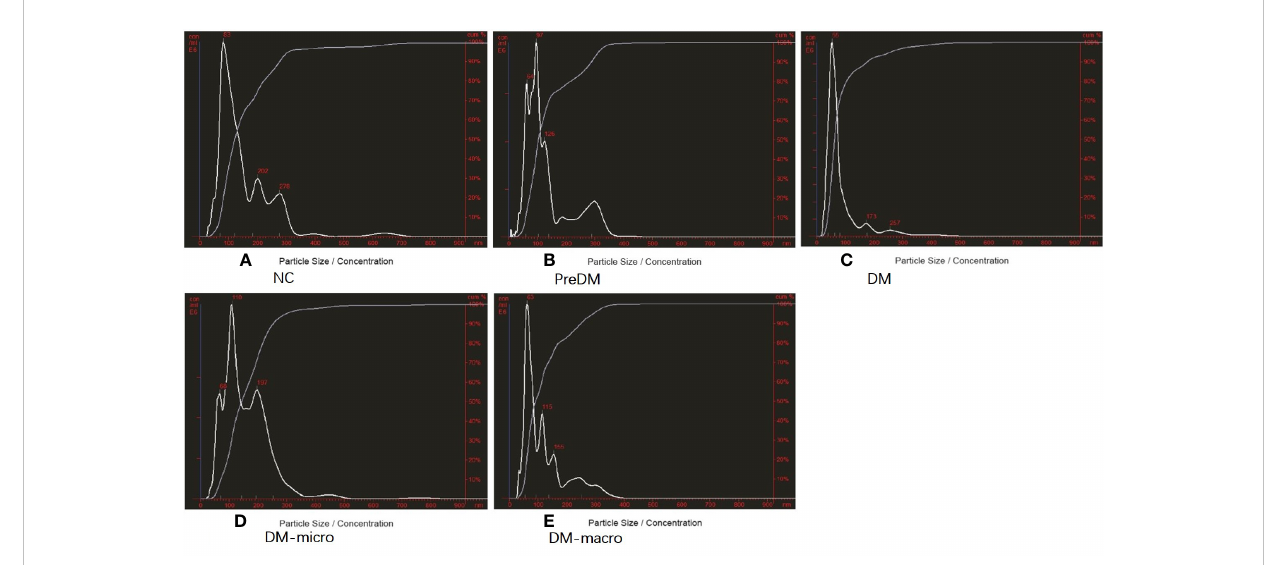
FIGURE 3 Purity of uEVs by NTA. (A) . Purity of uEVs under NTA in NC. (B) . Morphology of uEVs under TEM in Prediabetes. (C) . Morphology of uEVs under TEM in Diabetes with normal proteinuria. (D) . Morphology of uEVs under TEM in Diabetes with microalbuminuria. (E) . Morphology of uEVs under TEM in Diabetes with macroproteinuria. NC, normal controls; PreDM, Prediabetes; DM, diabetes with normal proteinuria; DM-micro, diabetes with microalbuminuria; DM-macro, diabetes with macroproteinuria.